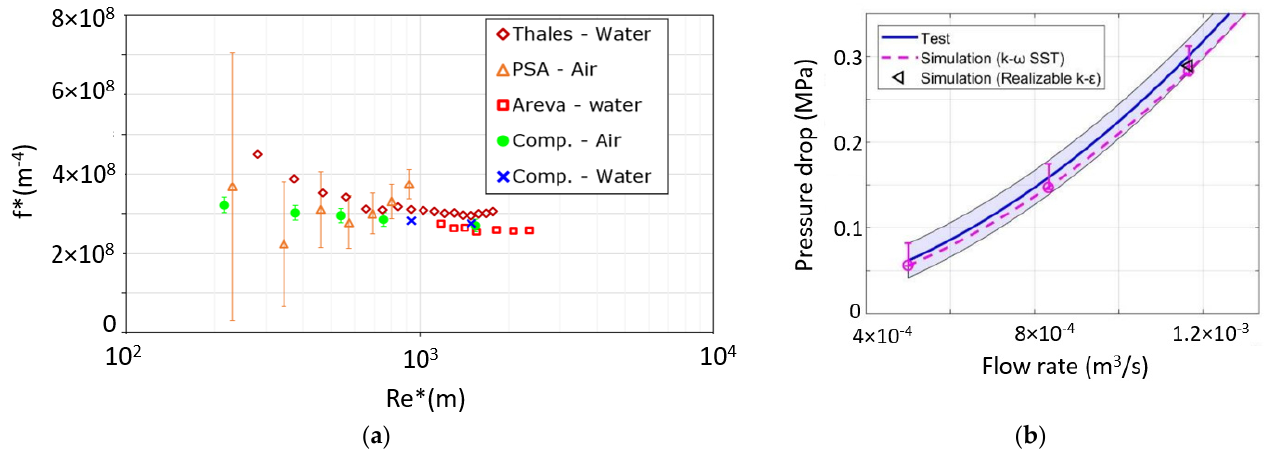
Figure 7. ( a ) Pseudo-dimensionless hydraulic characteristic (Re* as a function of f*) of the planar mock-up equipped with RR: experimental (open symbols) and computed (solid symbols) (modified from [32]). ( b ) Comparison between measured and simulated hydraulic characteristic for the cylindrical mock-up equipped with RRs (modified from [31]). The shaded area represents the error band on the experimental results.